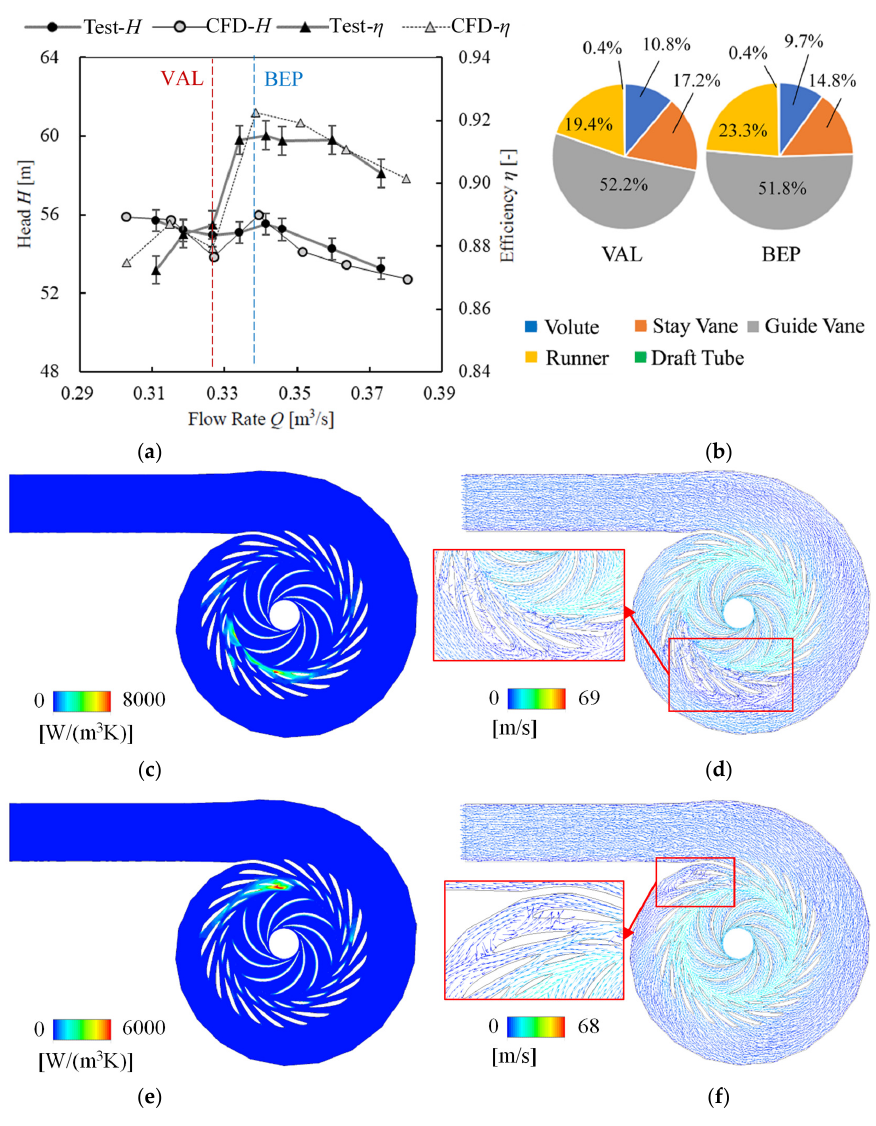
Figure 7. Performance curve and flow pattern at 16 ◦ attack angle. ( a ) Q-H and Q- η curve; ( b ) proportion of flow energy loss; ( c ) VAL S pro ; ( d ) VAL v ; ( e ) BEP S pro ; ( f ) BEP v ; VAL: local valley of Q-H curve; BEP: best efficiency